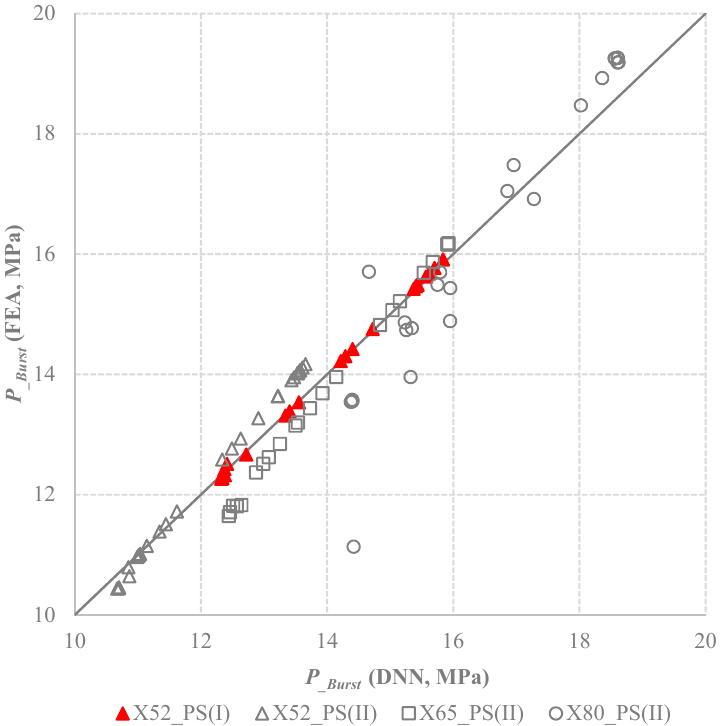
Figure 12. Pearson’s product-moment correlation coe ffi cient (PPMCC) between the burst pressure computed by the DNN model and the FEA based parametric study results for the pipeline with a hemispherical dent.